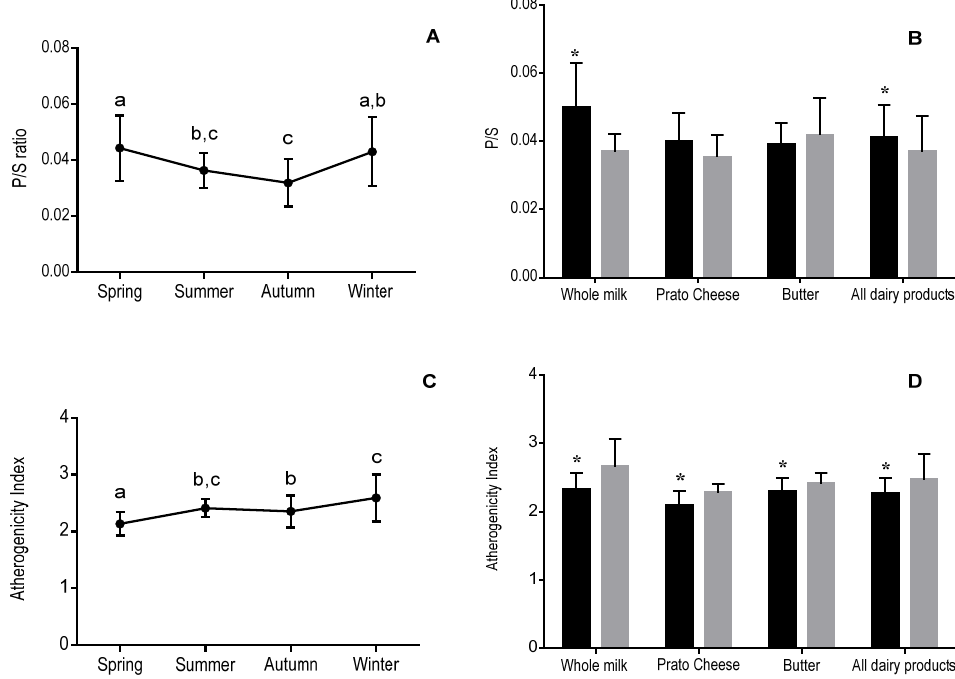
Figure 1. Seasonal variation in polyunsaturated ‐ to ‐ saturated fatty acid ratio (P/S; A ), atherogenicity index (AI; C ), and effects of rainy and dry seasons on P/S ( B ) and AI ( D ) of Brazilian dairy products. Data from all dairy products were combined. AI = (C12:0 + (4 × C14:0) + C16:0)/(sum of unsaturated fatty acids). ( A and C ): Data points and error bars represent means and standard deviations, respectively. Means sharing a lowercase letter are not significantly different by ANOVA with Tukey’s post ‐ test ( p < 0.05). ( B and D ): Spring and summer were the rainy seasons ( and autumn and